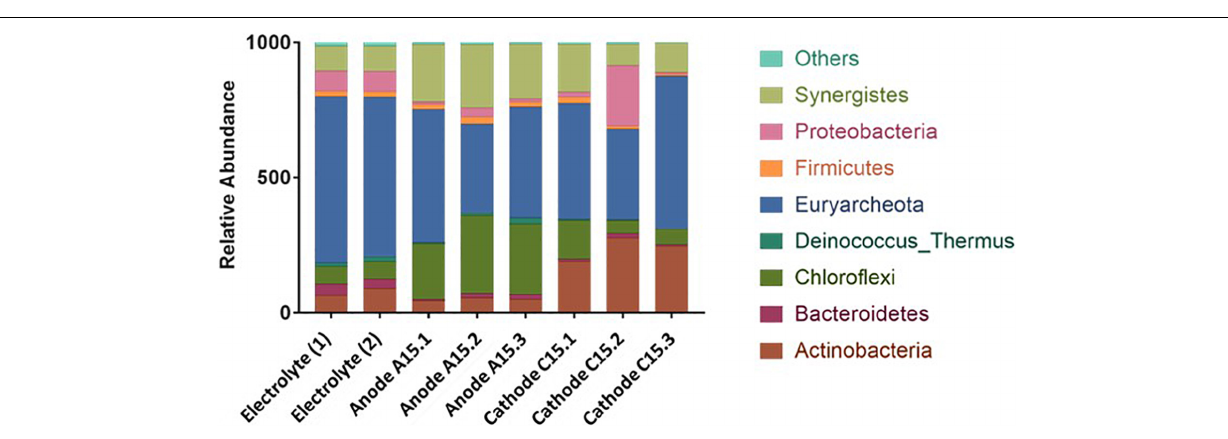
) of the phyla identified in the bulk electrolyte, anode and cathode biofilms of module 15 (samples taken on day 211). FIGURE 6 | Relative abundance ( (cid:104)